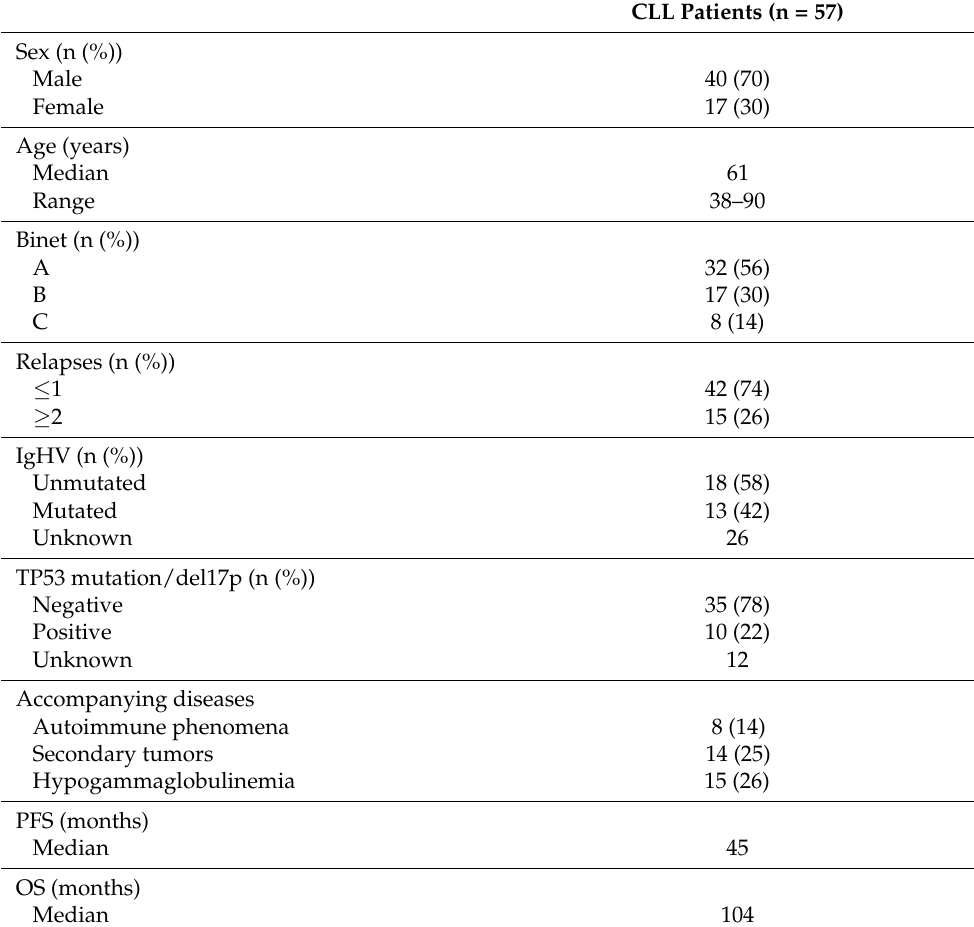
Table 1. Characteristics of CLL patient